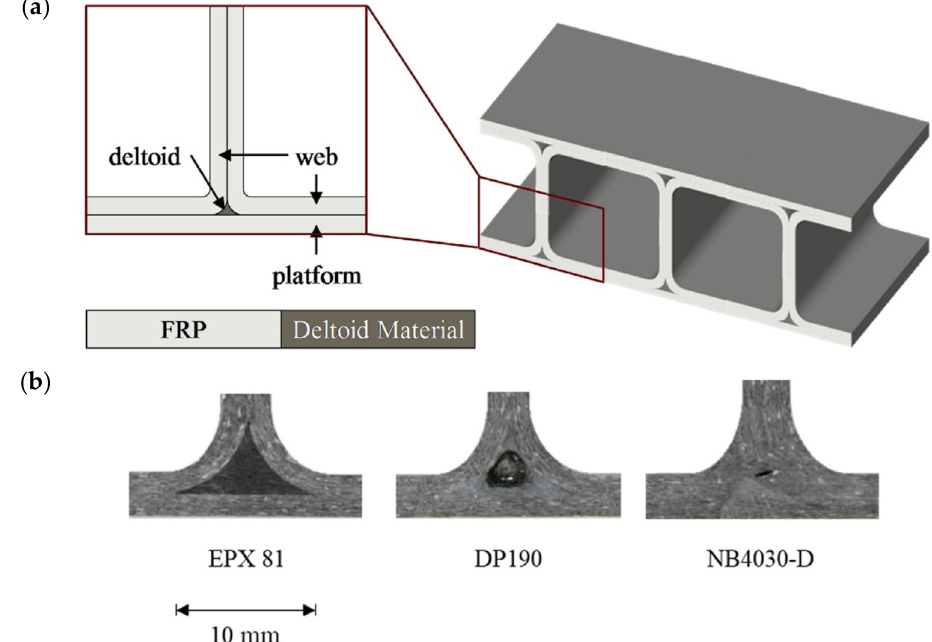
Figure 8. ( a ) Schematic cross-section of a T-joint (left) and schematic 3D drawing of a spar-wingskin joint (right). ( b ) Close-up of deltoid areas for T-joints filled with the EPX 81, a commercial epoxy adhesive (DP190) and a prepreg inserted. It can be seen how the deltoid manufactured with the 3D printed dual-cure epoxy shows an exact geometry and a good material distribution along the bond line without voids or discontinuities. Reproduced from [61] with permission from Elsevier.